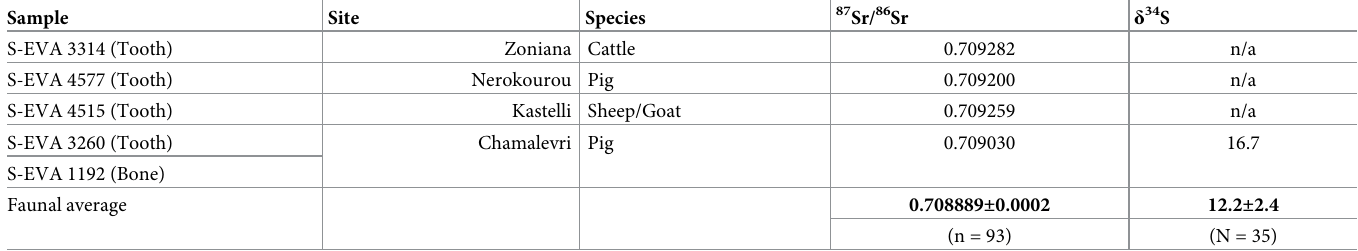
Table 2. The strontium and sulphur isotope values of three faunal samples that have values higher than the marine strontium value and one faunal sample that has a sulphur isotope value outside the average values for fauna from Crete. Also included are the average faunal values for strontium and sulphur isotopes from this